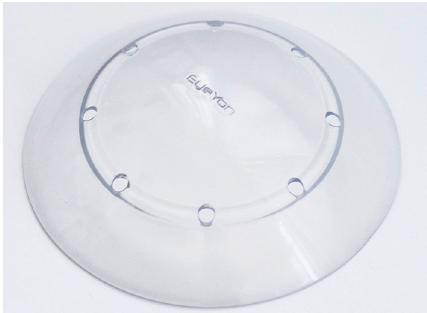
Figure 1: Therapeutic Hyper-CL ™ lens design. The lens design consists of a dual base curve, fenestrations, and a reservoir for accumulation of therapeutic solutions.